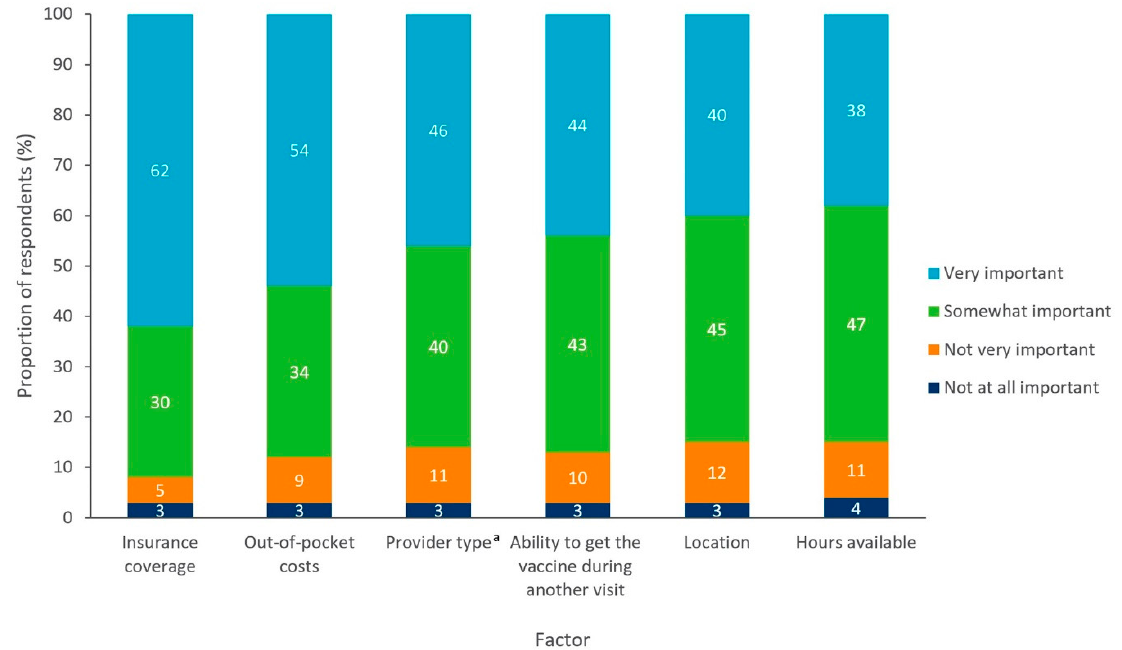
Figure 7. Factors influencing the receipt of a vaccine for all respondents without religious objections (n = 4917). a Provider type referred to whether vaccines are administered by a primary care doctor, specialist doctor, pharmacist, etc.